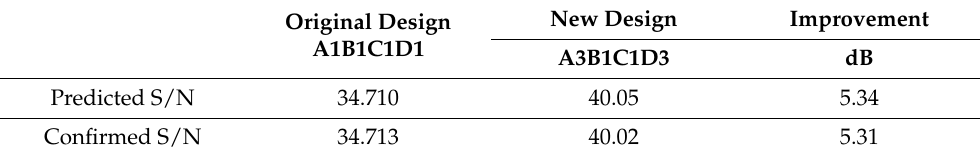
Table 6. Improvement of the original factory and new